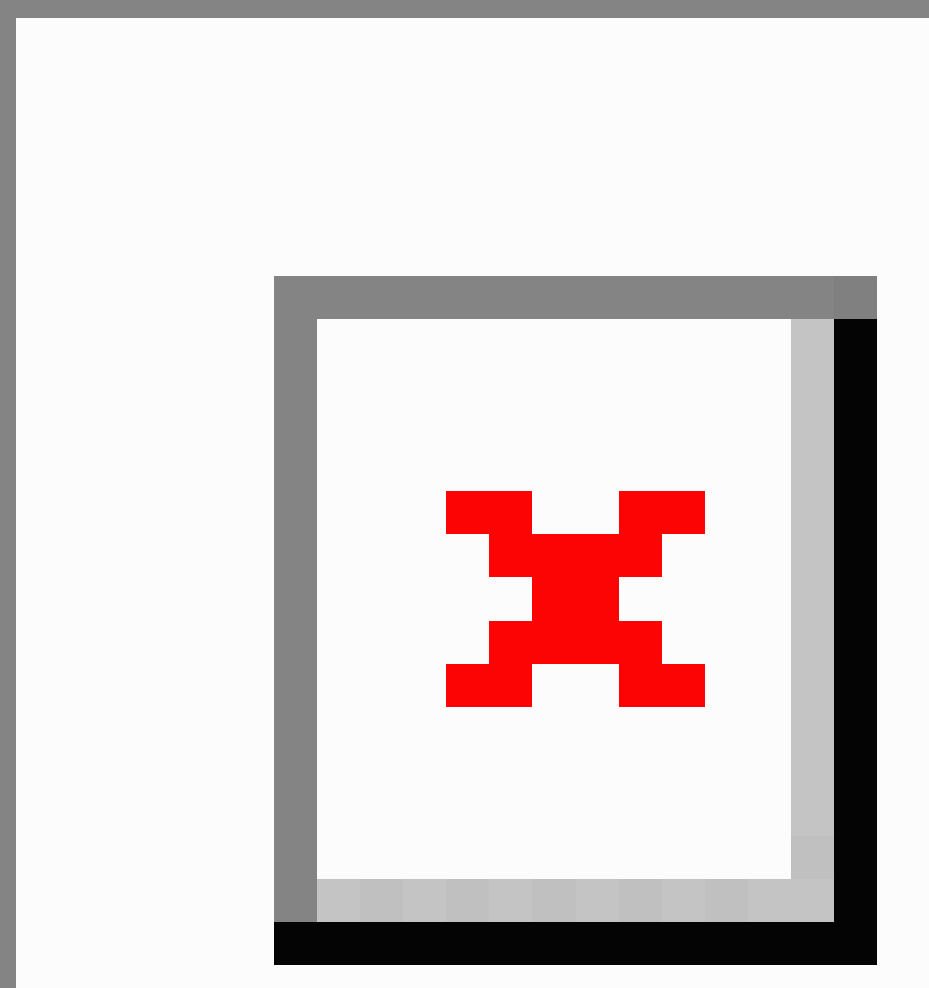
Figure 2. Flow of the citations reviewed as part of the systematic review